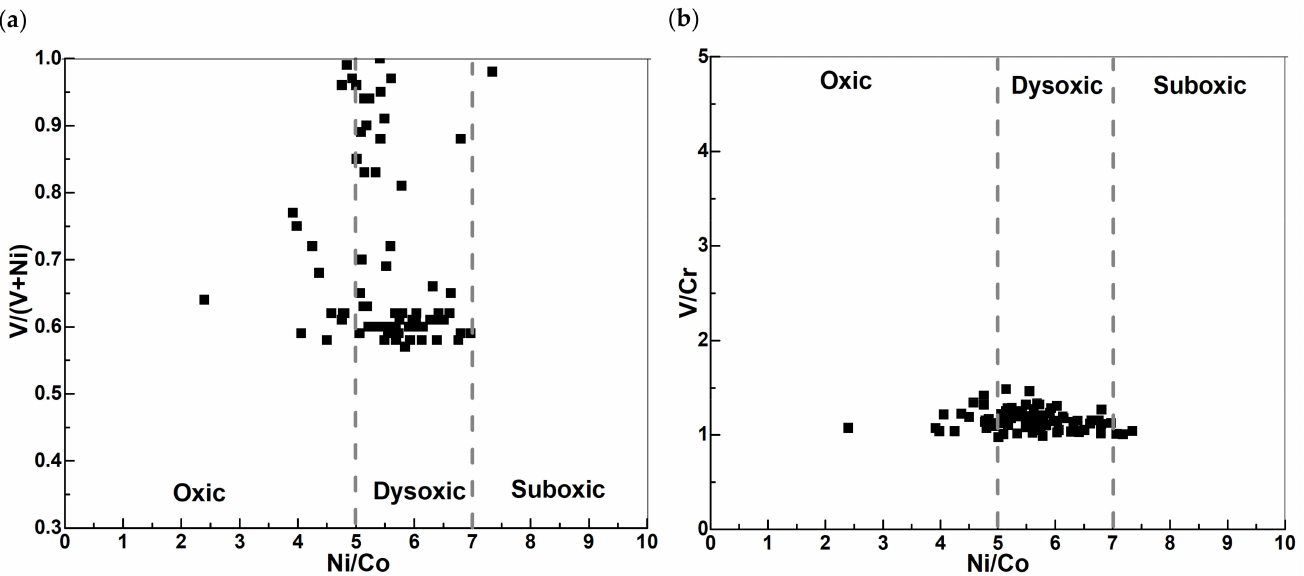
Figure 6. Bivariate plots of trace element ratios: ( a ) Ni/Co vs. V/(V + Ni); ( b ) Ni/Co vs. V/Cr, used as paleoredox proxies for the past 100 ka in the sediment core SK117/GC08. Boundaries between different redox conditions after Jones and Manning